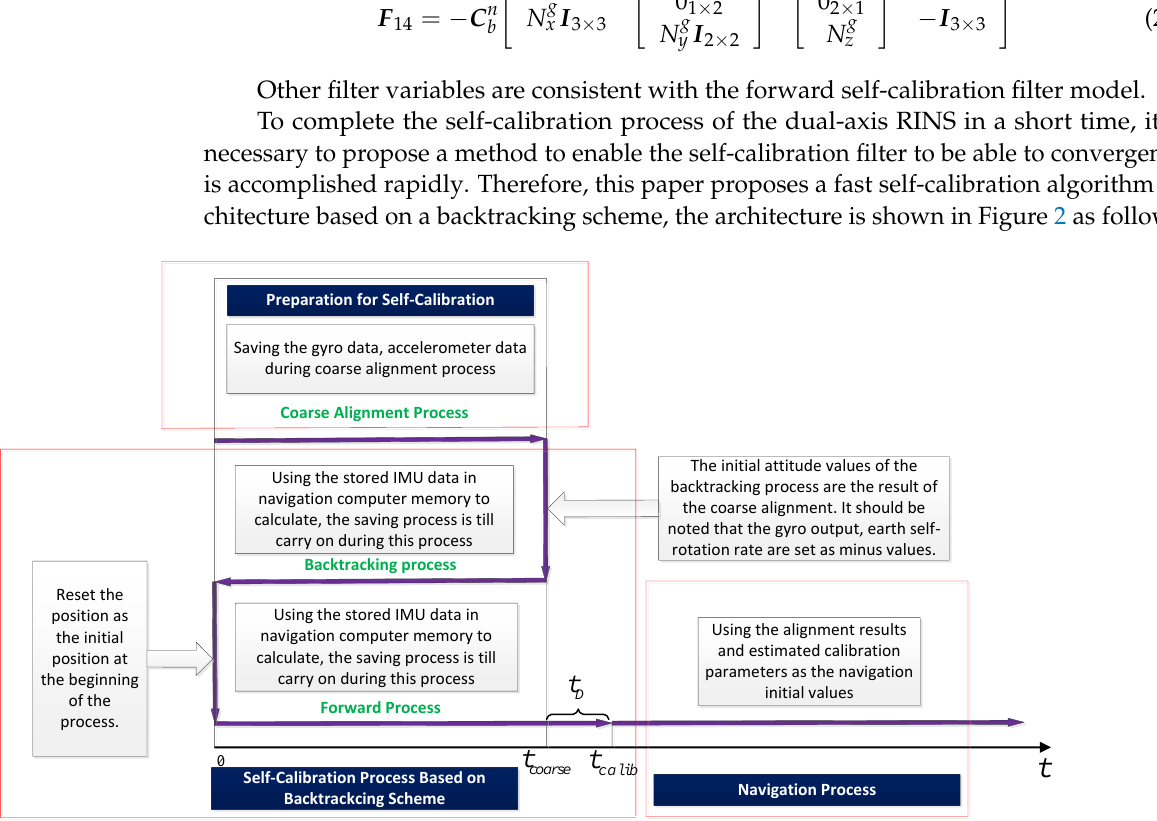
Figure 2. Diagram of self-calibration process based on backtracking